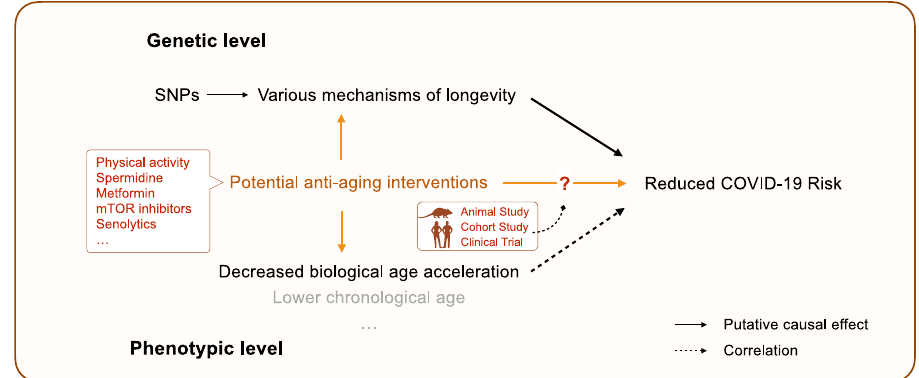
Fig. 6 Schematic diagram showing the link between aging and COVID-19. Black solid arrows show the causal effect established by Mendelian Randomization analysis, and the black dashed arrows show the correlation observed in the UKBB cohort. Orange arrows show potential approaches to reduce COVID-19 risk. SNPs single nucleotide